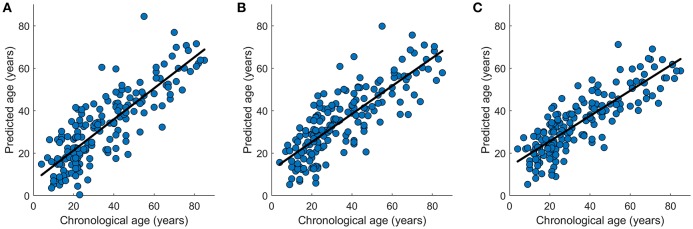
Graphical representation of the age prediction results. (A) Chronological age (x-axis) vs. predicted age (y-axis) acquired by OLS regression model. (B) Chronological age (x-axis) vs. predicted age (y-axis) acquired by SVR regression model. (C) Chronological age (x-axis) vs. predicted age (y-axis) acquired by Lasso regression model. The curve fits are shown by the dark lines.